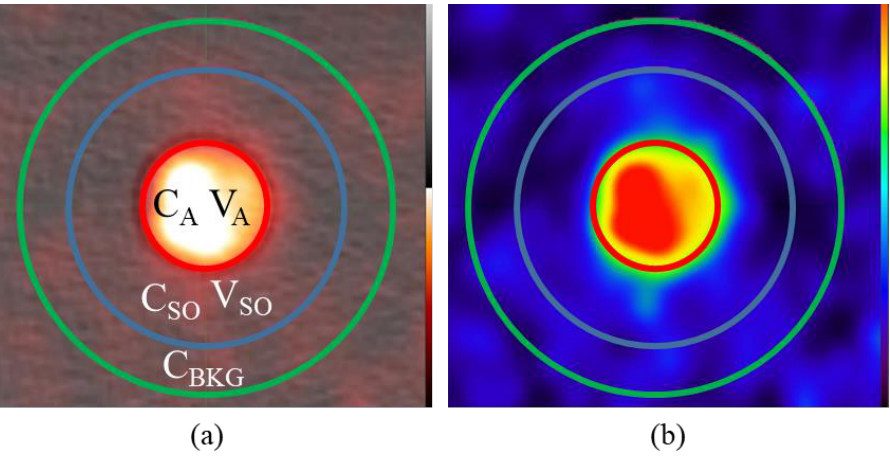
Figure 2. Partial volume correction in the presence of background. ( a ) In addition to C A /V A and C SO /V SO an additional region outside of the “spill-out” region is selected as the background concentration C BKG is outlined in green. ( b ) Visualization of the “spill-out” from the V A region into V SO is still evident even in the presence of background shown on the PET only.